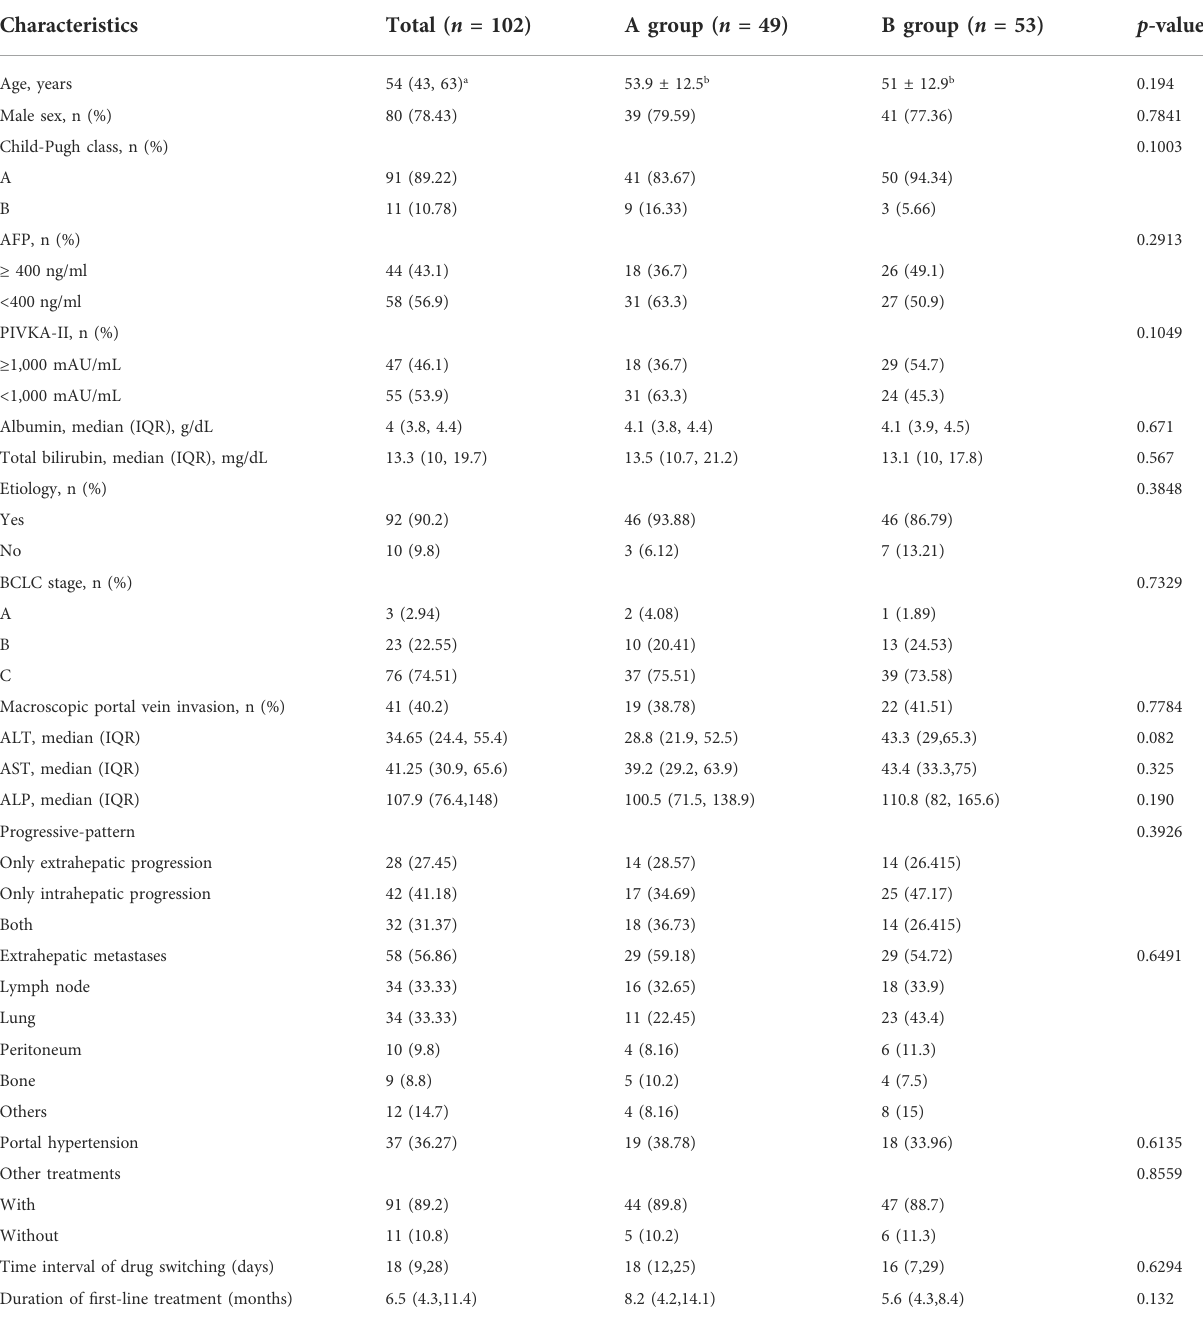
TABLE 3 Clinicopathological characteristics of hepatocellular carcinoma